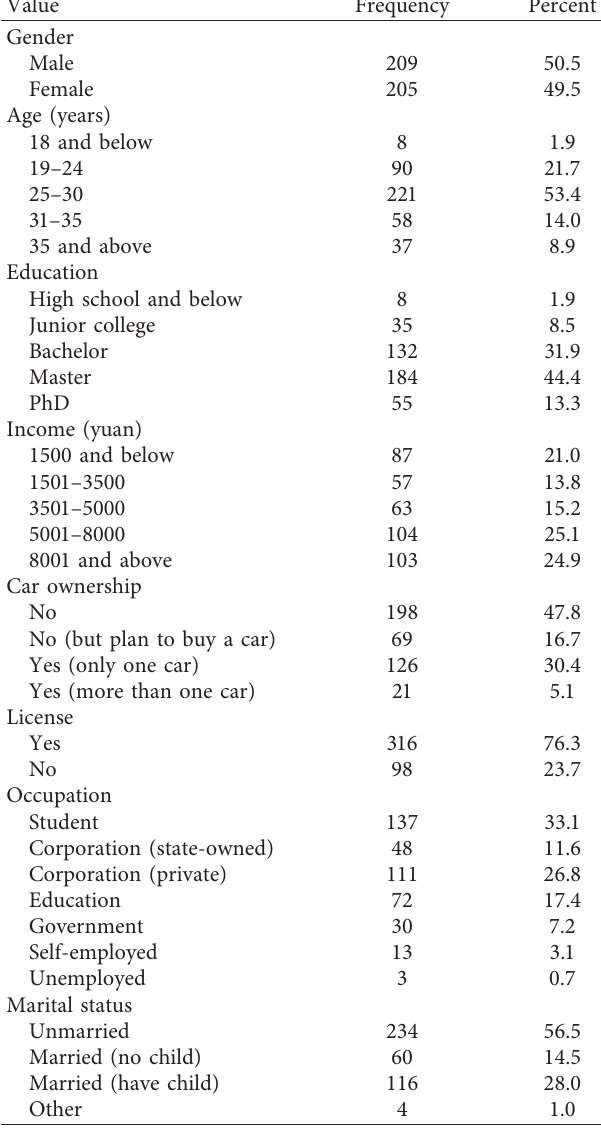
Table 3: Descriptive analysis of sociodemographic